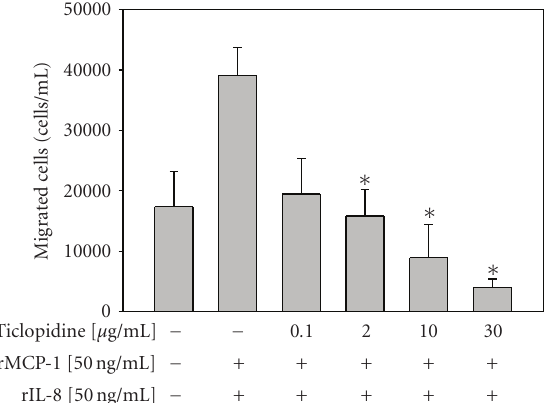
Figure 5: Reduction of U937 cells chemotaxis by ticlopidine. HUVECs were incubated at the upper wells of the transwell plates until confluency, then di ff erent concentrations of ticlopidine were added. After 30minutes of incubation, cells were stimulated with/without TNF- α (10ng/mL). U937 cells were added to the upper chamber wells and incubated for 1.5 hours. The cells chemotastic to the lower wells were counted. Data are expressed as the mean ± SEM of three individual experiments. Significantly di ff erent versus TNF-treated alone ∗ P < .05, ∗∗ P <